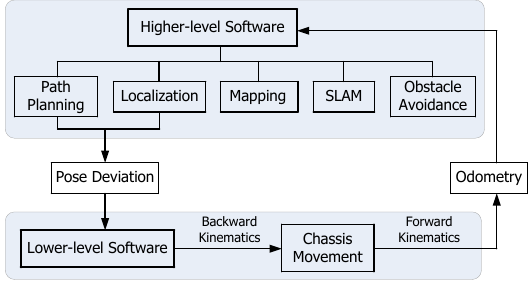
Figure 6. Schematic diagram of the control software.